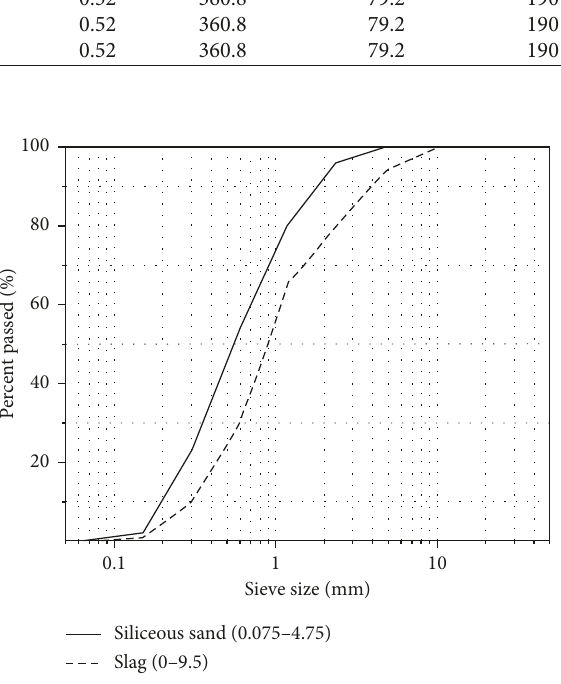
Figure 1: Gradation of aggregate fractions.